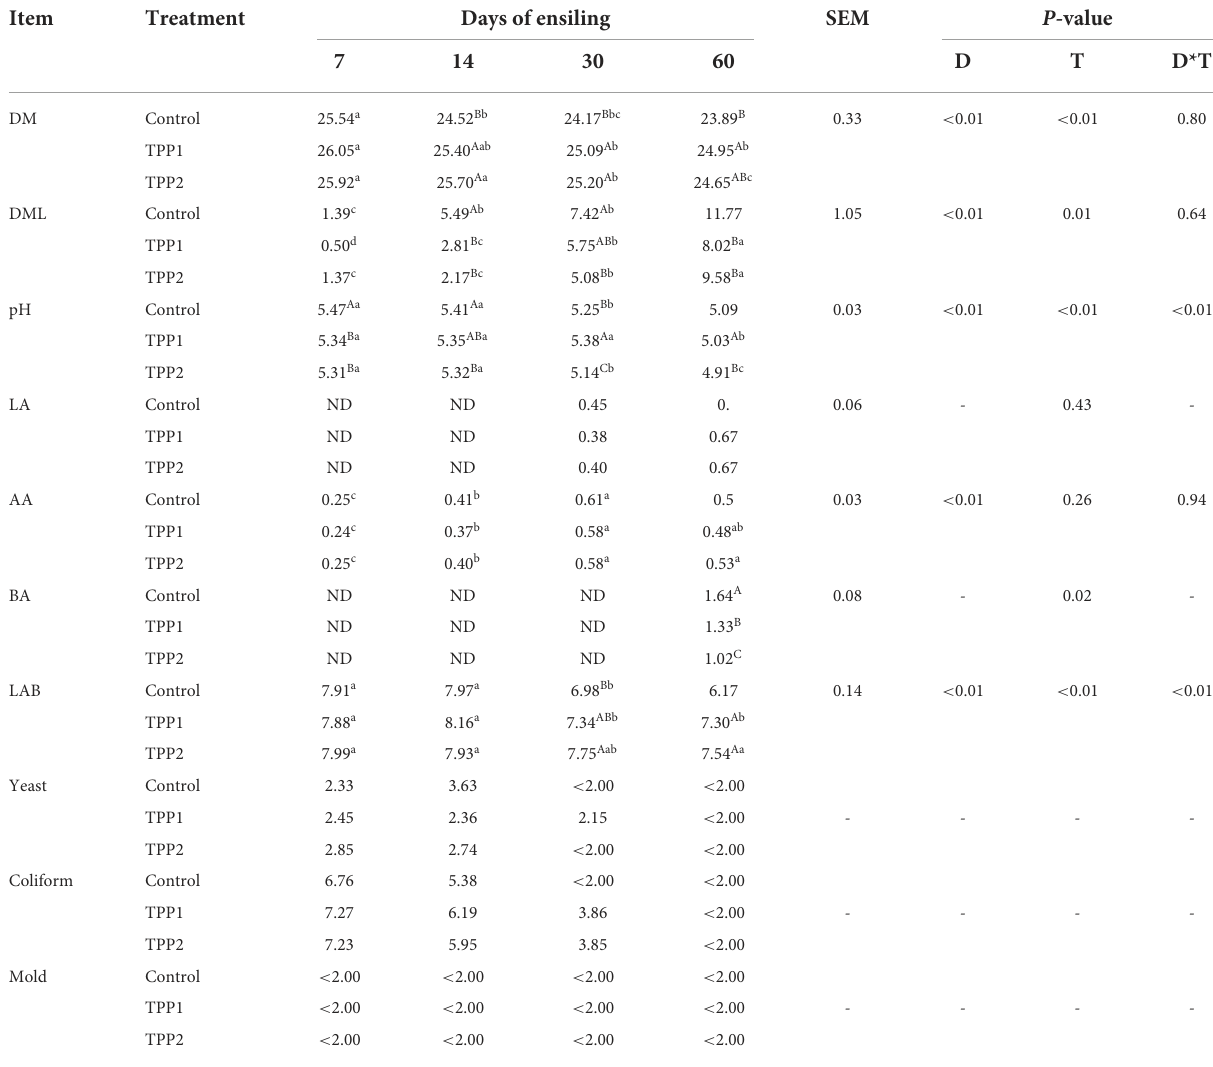
TABLE 2 Effect of tea polyphenols on the dynamic fermentation of stylo